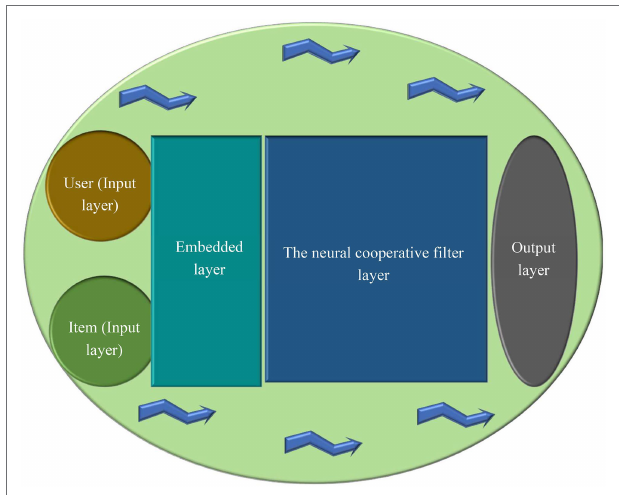
FIGURE 4 | Framework of neural collaborative filtering algorithm